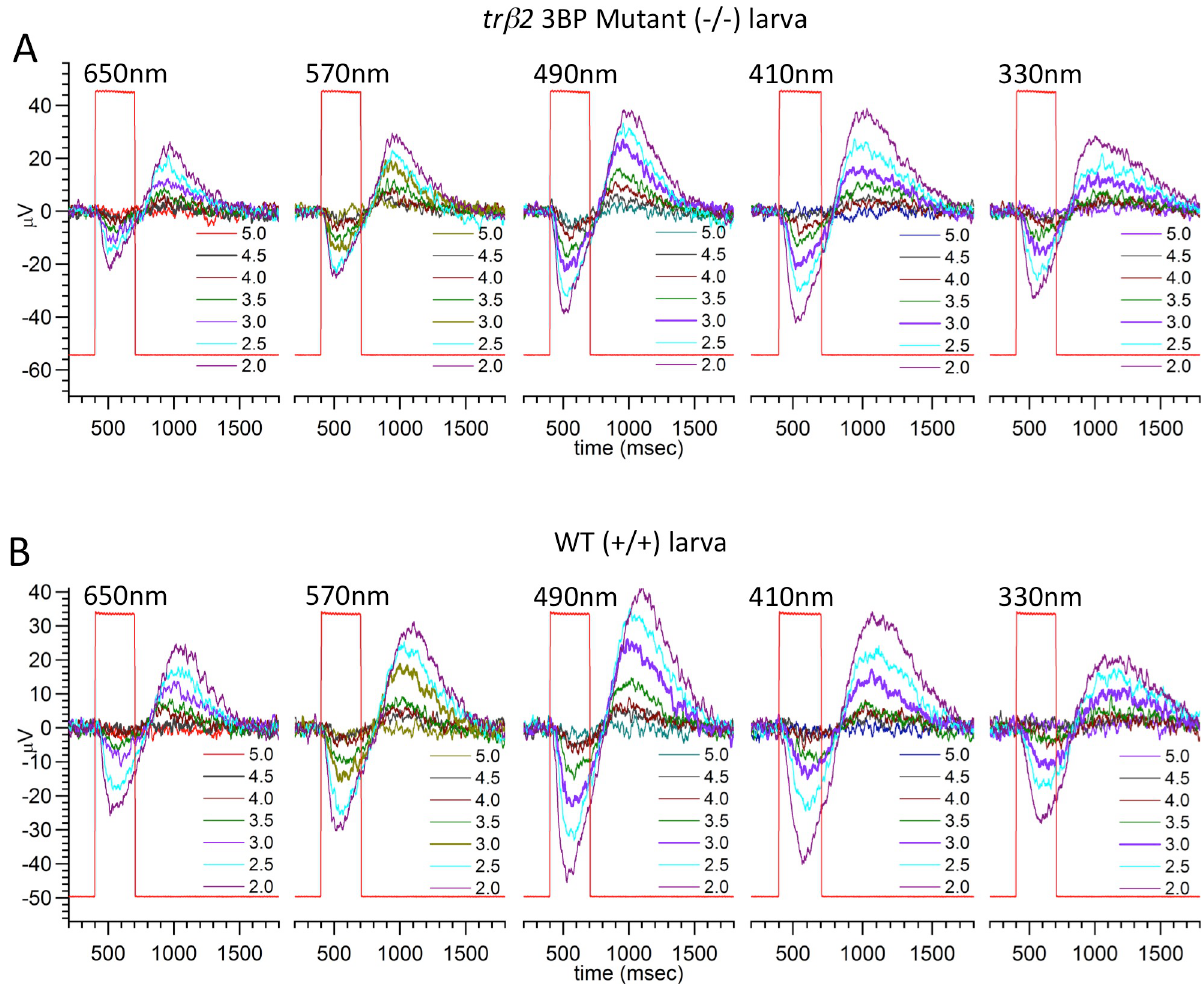
Fig 7. 3BP larval cone PIII ERG spectral response traces. (A) The 3BP mutant larva (N = 17, 70-point spectral dataset) responds to all wavelengths from 650–330 nm, with no significant differences from the wild type control (N = 17, 70-point spectral datasets) (B). Larvae are 5